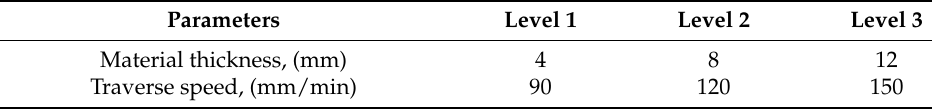
Table 4. Variable input parameters values.